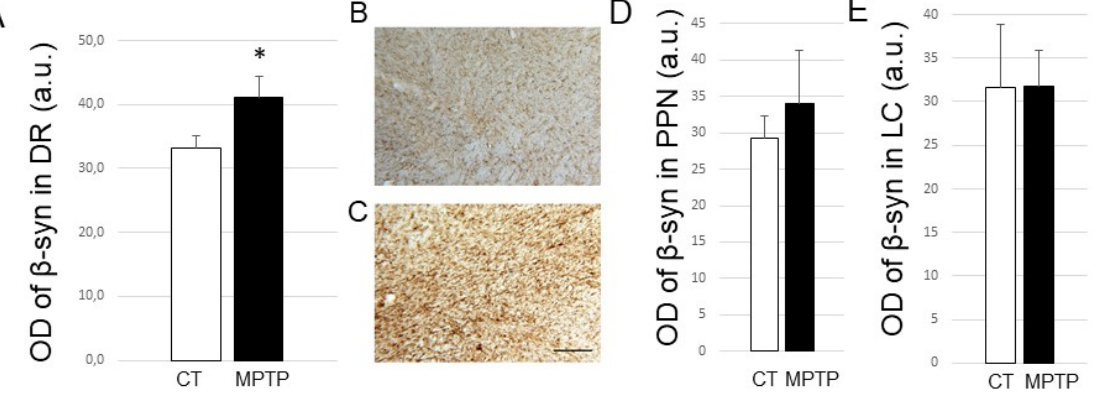
Figure 4. ( A ) Histogram represents optical density of β -syn (in arbitrary units) in DR from control (CT, n = 5) and MPTP-intoxicated (MPTP, n =6) animals. * p < 0.05 when compared to controls. ( B , C ) Photomicrographs at high magnification (×16) of coronal sections of a control (MF14) and an MPTP- intoxicated (MF18) Macaca fascicularis, exemplifying β -syn labeling obtained at the level of the dor- sal raphe. Scale bar on C is 100 µm. ( D ) Histogram represents optical density of β -syn (in arbitrary units) in PPN from control (CT, n = 4) and MPTP-intoxicated (MPTP, n = 3) animals. ( E ) Histogram represents optical density of β -syn (in arbitrary units) in LC from control (CT, n = 3) and MPTP- intoxicated (MPTP, n = 3) animals. Abbreviations: a.u, arbitrary units; OD, optical density; DR, dor- sal raphe; CT, control; LC, locus coeruleus.